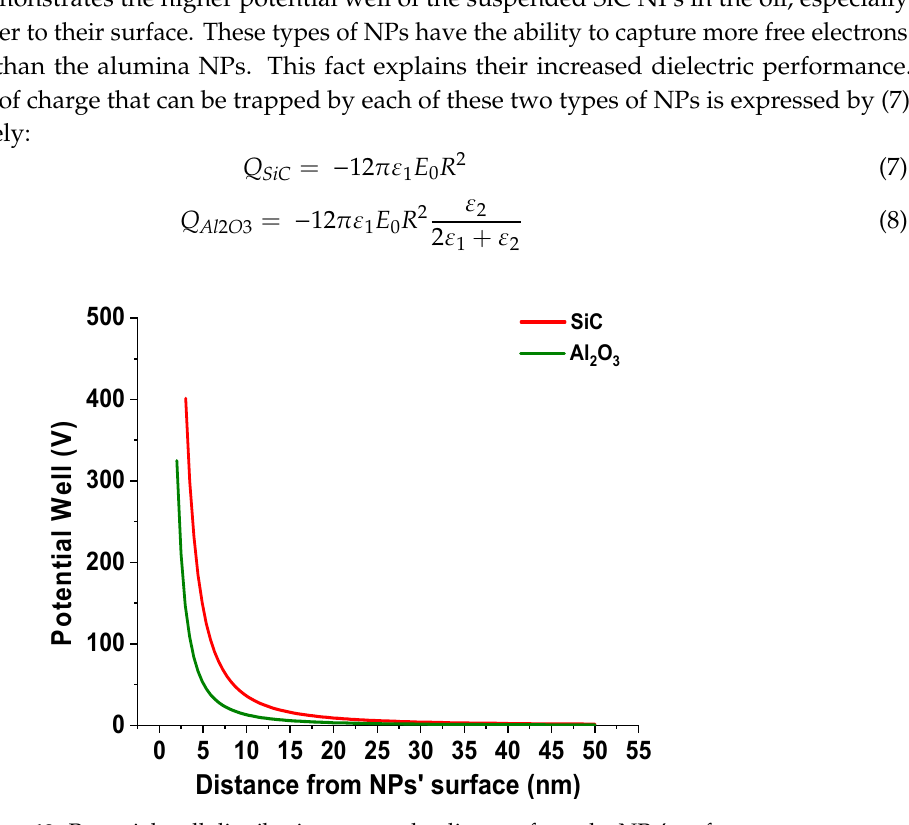
Figure 12. Potential well distribution versus the distance from the NPs’ surface.